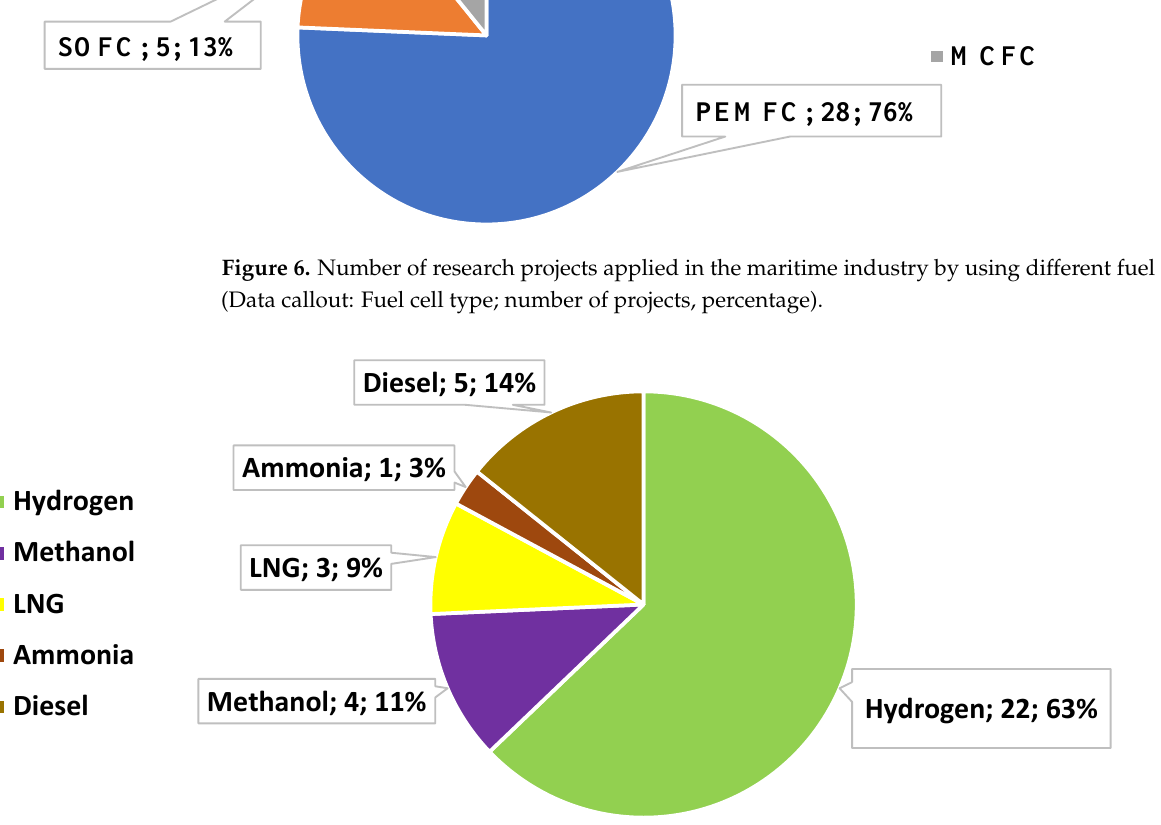
Figure 7. Number of research projects applied in the maritime industry by using different fuel types (Data callout: Fuel type; number of projects, percentage).